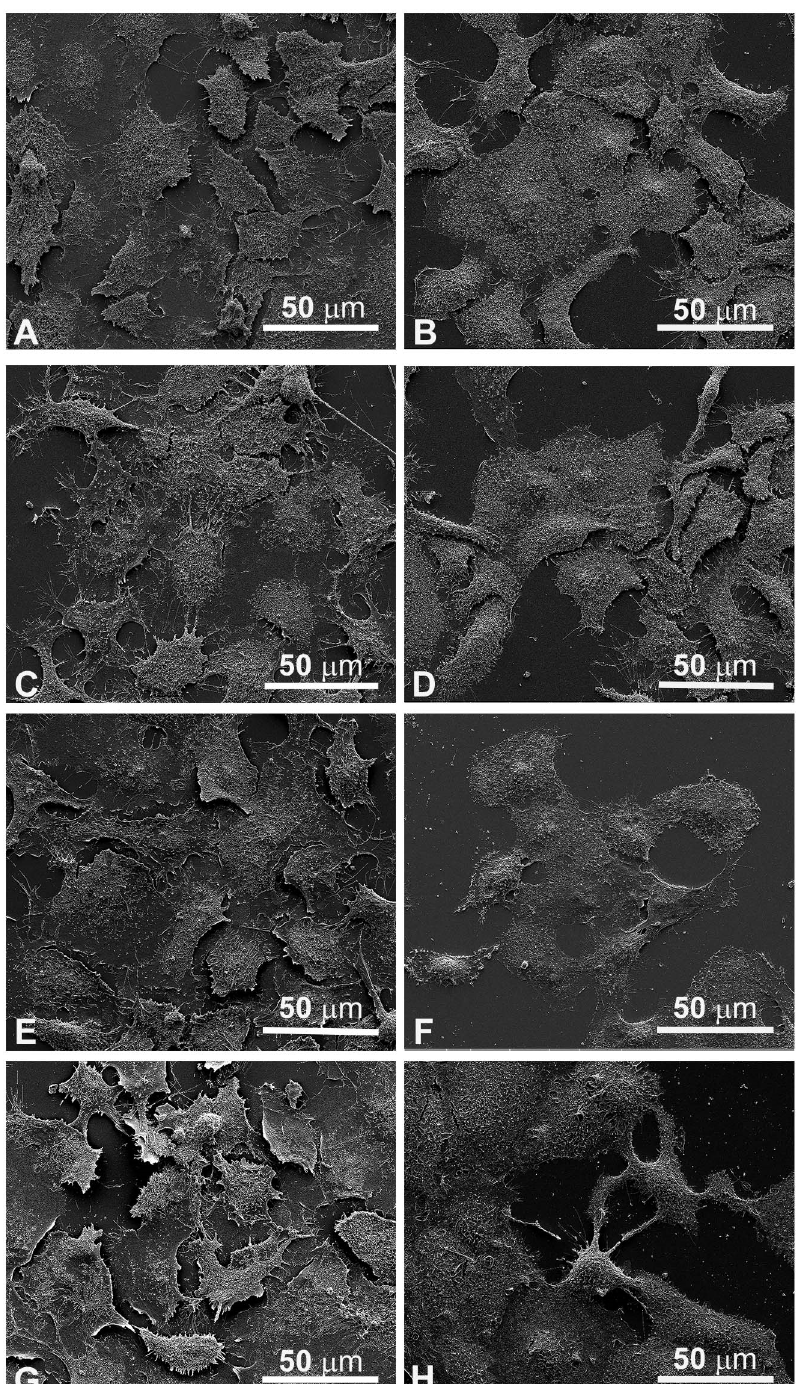
Figure 5. Scanning electron microscopy observations of FaDu cells (left panel) and CAL 27 cells (right panel) for 24 h after treatment. ( A , B ) Control, no treatment; ( C , D ) single EP; ( E , F ) MMC (5 µ M); ( G , H ) combined treatment (EP +